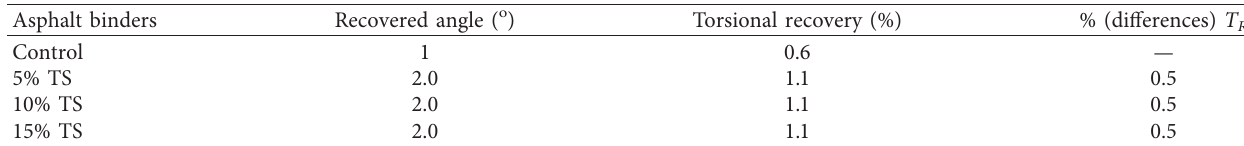
Table 12: Torsional recovery results of TS modified binders.